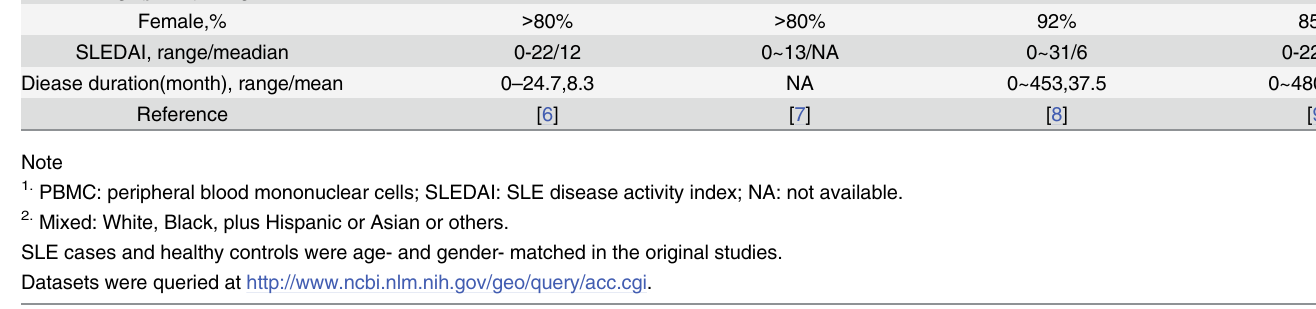
datasets and related samples, as published in the original articles and/or released with the data- sets, were collected and presented in Table 1 .